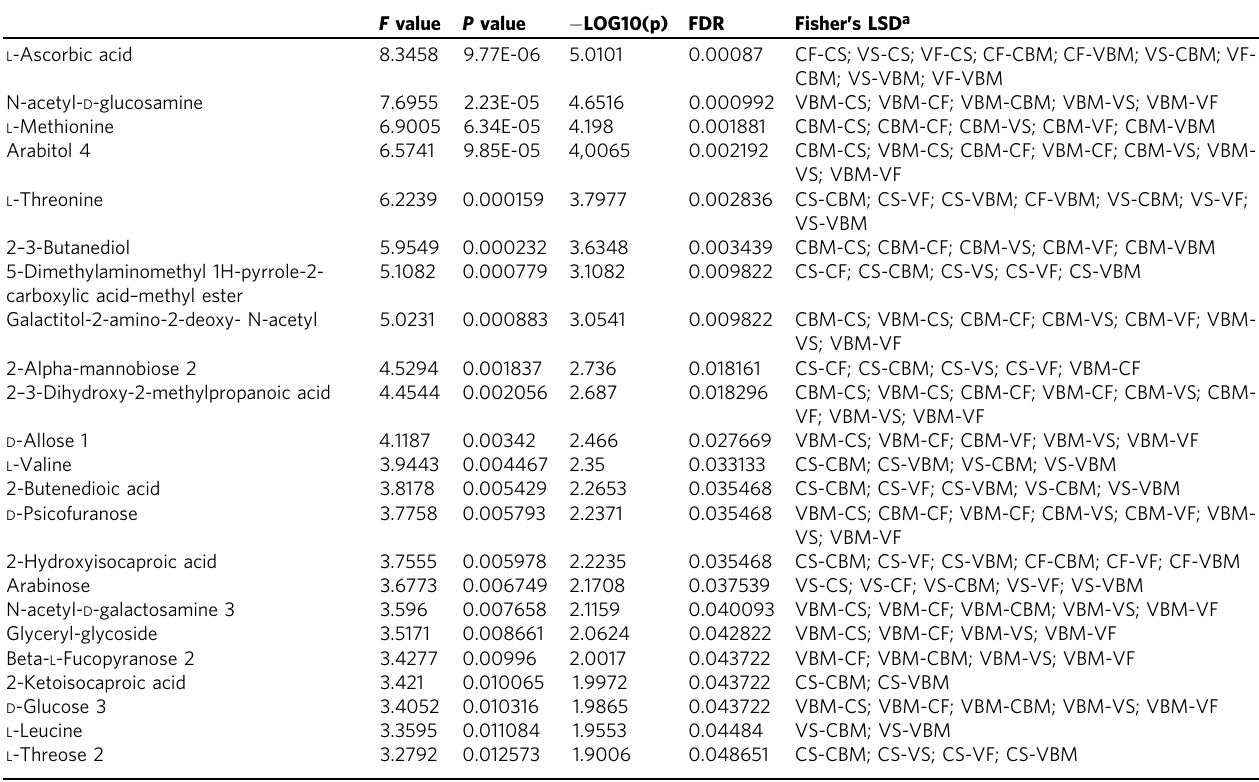
Table 5 List of signi fi cant metabolites among groups at